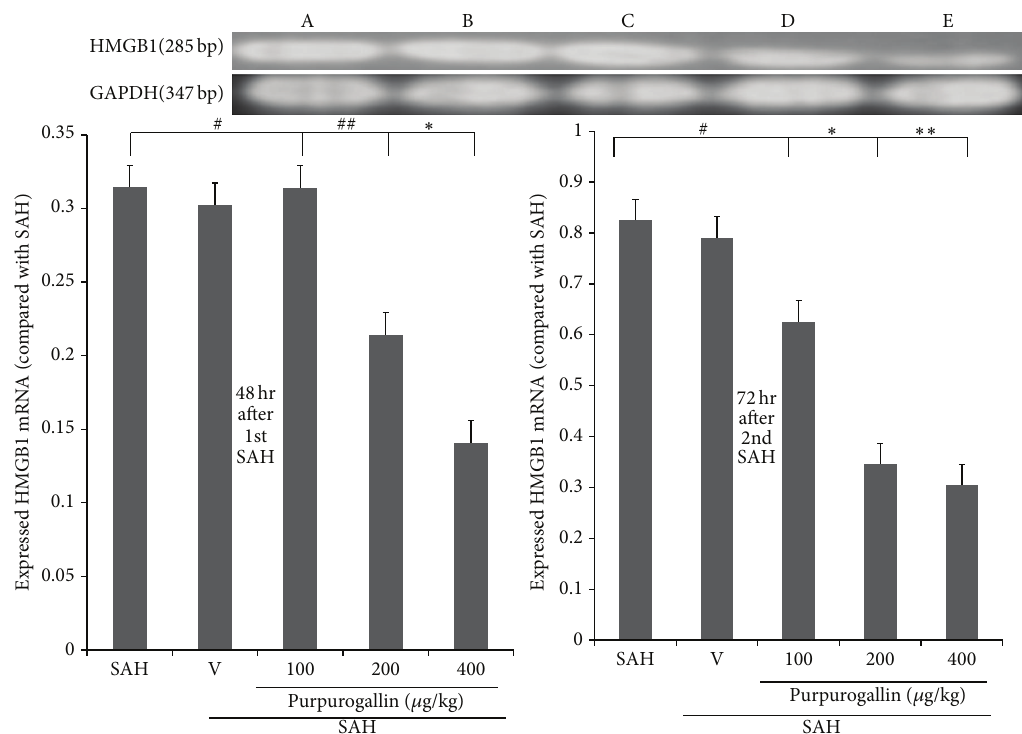
Figure 4: HMRB1mRNA expression on 48 hr after first SAH and 72 hr after second SAH, respectively (rt-PCR). All groups are identical to those shown in the legends of Figure 3. # , ## 𝑃 > 0.05 ; ∗,∗∗ 𝑃 < 0.01 : represents purpurogallin treatment (48 hr after first SAH); purpurogallin dose-dependently (72 hr after second SAH) attenuated HMGB1 mRNA transcription, when compared with the SAH